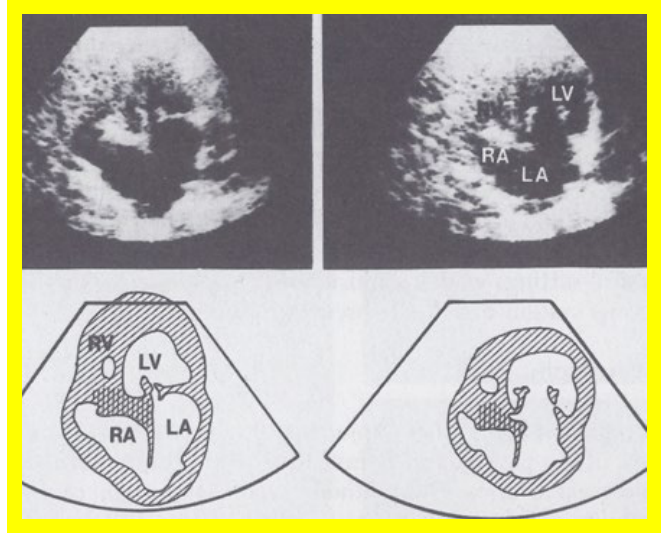
Figure 3. Selected video frames from apical four chamber view of a two dimensional (2D) echocardiographic study, demonstrating a dense band of echoes between the right atrium (RA) and hypoplastic right ventricle (RV). Line drawings are shown beneath the 2D frames. Note that the mitral valve is closed in the left image, while it is open in the right image. The atretic tricuspid valve echoes remain unchanged. LA, left atrium; LV, left ventricle. Reproduced from Reference [24].